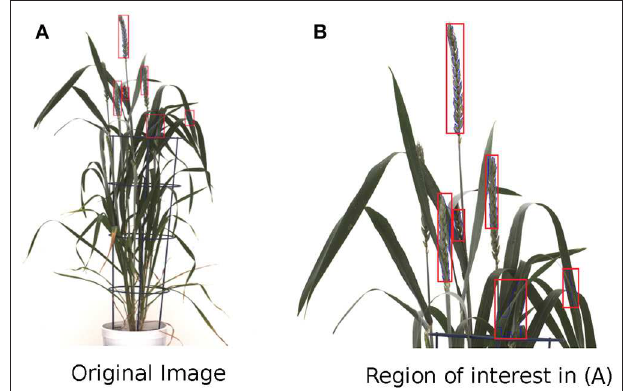
FIGURE 1 | Limitations of wheat spike detection using the Qiongyan et al. (2017) algorithm. (A) The detection of spike and non-spike pixels in the wheat plant. (B) Zoomed version of detected pixels in (A)